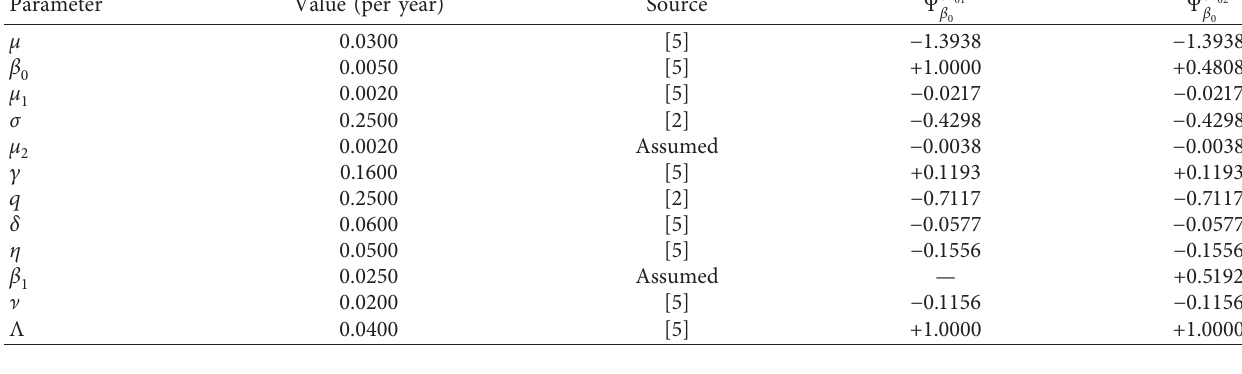
Table 1: Sensitivity analysis of basic mode parameters in R